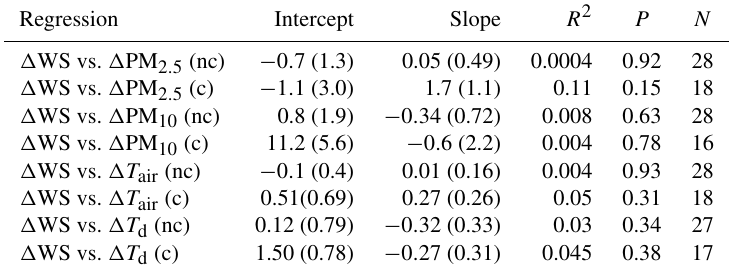
Table 1. Regression parameters for several surface variables of the Column virga cases (c) and not column virga cases (nc). WS is the wind speed, PM 2 . 5 is the particulate matter at 2.5µm, PM 10 is the particulate matter at 10µm, T air is the air temperature, and T d is the dew point temperature. The linear fit parameters are as follows: R 2 is the squared correlation coefficient, P is the p value, and N is the sample size. Values in parenthesis are the standard error. Regression Intercept Slope R